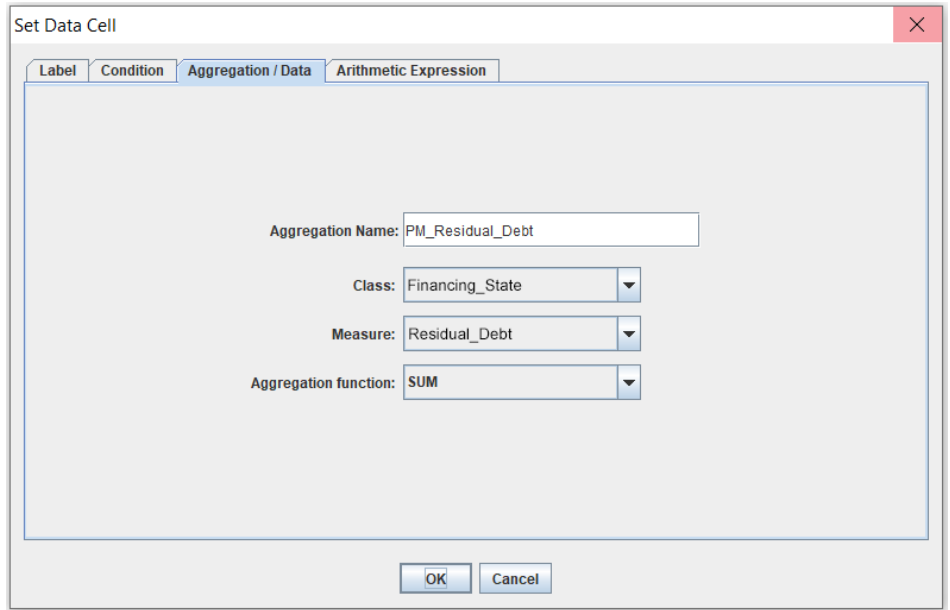
Figure 16. Report Designer : user interface for defining “Aggregation